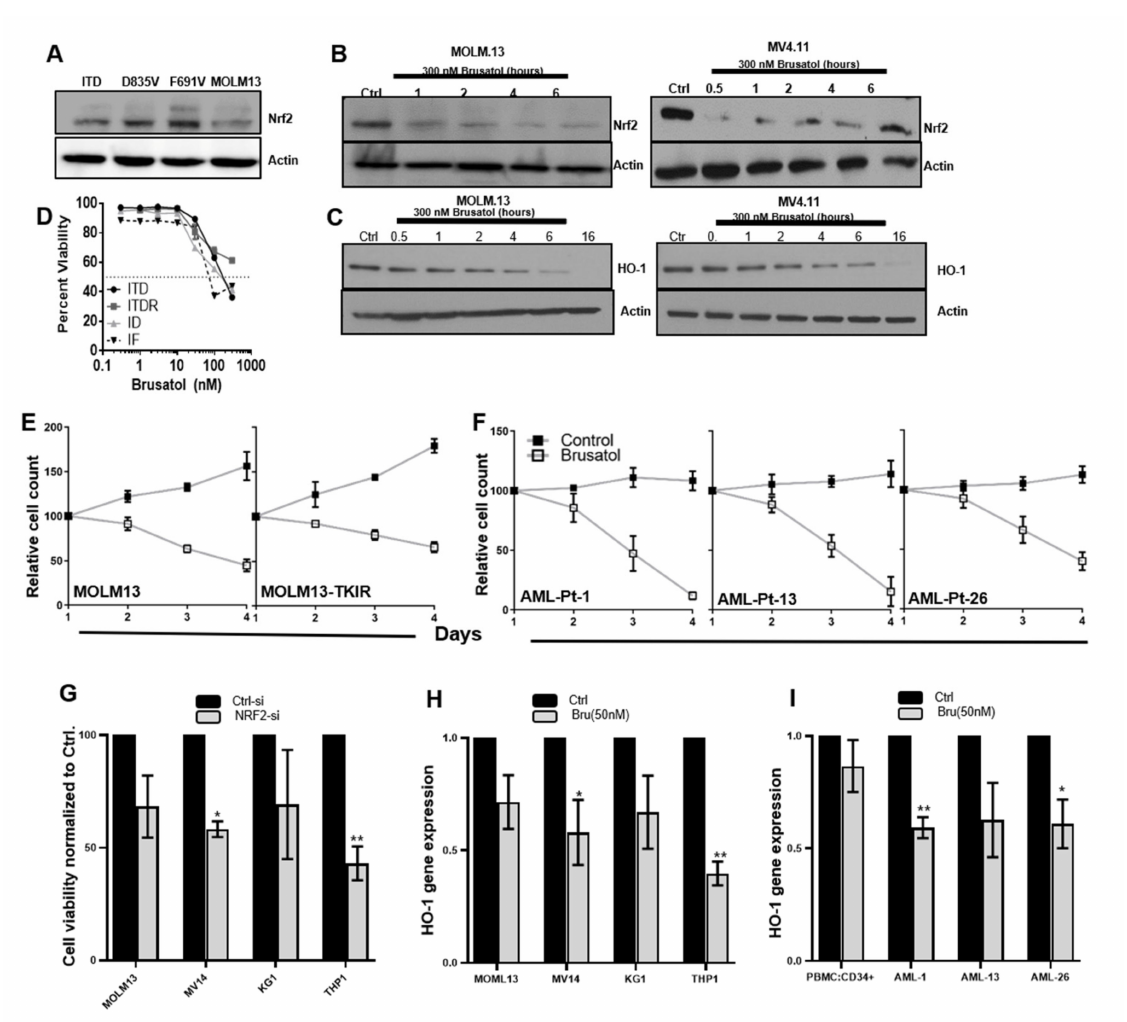
Figure 3. NRF2 inhibition decreases HO-1 expression and inhibits viability in AML. ( A ) Western blot analysis was performed on a panel of cell lines expressing FLT3-ITD (ITD, MOLM13) or FLT3-ITD mutants (D835V, -F691V, and MOLM13) to determine NRF2 and actin protein expression ( B , C ). MOLM13 and MV4.11 human ITD-expressing cell lines were treated with brusatol and cells were harvested at different time points for lysate preparation and Western blot analysis of NRF2 ( B ), HO-1 ( C ) and actin (both) protein expression was determined at indicated timepoints. ( D ) TKI-sensitive Ba/F3-Flt3-ITD cells and -resistant ITD cells (-ITDR, -D835V, -F691V) were treated with brusatol at indicated concentrations for 72 h, and then cell growth was analyzed. The brusatol concentration that inhibited 50% of cell viability (IC 50 ) was determined from the dose–response curves. ( E ) MOLM13- sensitive and MOLM13-TKIR (tyrosine kinase inhibitor resistant) cells and ( F ) three patients’ primary AML samples were treated with NRF2 inhibitor brusatol (10 nM for 4-days) and vehicle, samples were stained with Alamar blue, and cell proliferation was measured quantitatively. ( G ) Cell viability assay was performed in a panel of AML cell lines after NRF2-si transfection in vitro. Transient knockdown of NRF2 by siRNA or control siRNA was allowed for 48 h, and cell viability was measured using ViCell counter. ( H ) HO-1 gene expression was measured from RNA lysates harvested from CD34+ve normal PBMC, and patients’ primary AML samples treated with 50 nM of brusatol for 24 h were harvested. HO-1 transcripts levels were measured by qRT-PCR. ( I ) HO-1 gene expression was measured from RNA lysates harvested from a panel of AML cell lines treated with 50 nM of brusatol for 24 h were harvested. HO-1 transcripts levels were measured by qRT-PCR. Statistical significance is shown as p -values less than 0.05 and 0.01 (* p < 0.05; ** p < 0.01). Experiments were repeated at least three